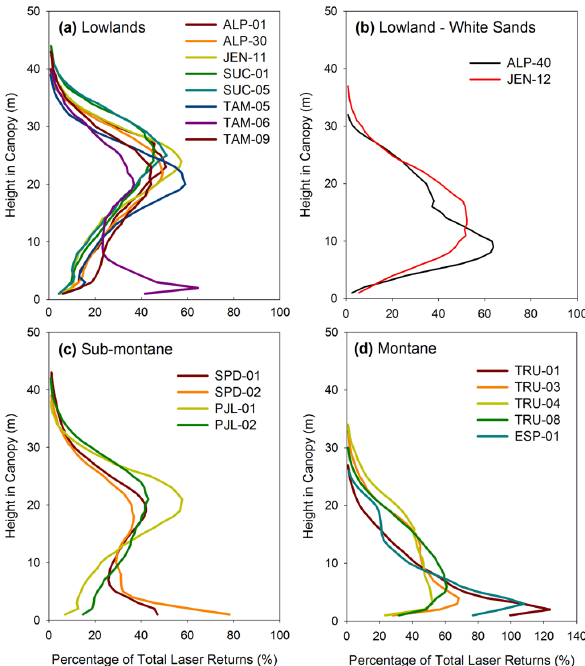
Fig. 4. Mean lidar vertical profiles for canopies in (a) lowland, (b) lowland on white sand soils, (c) sub-montane, and (d) montane forest landscapes. Site names match those provided in Table 1.